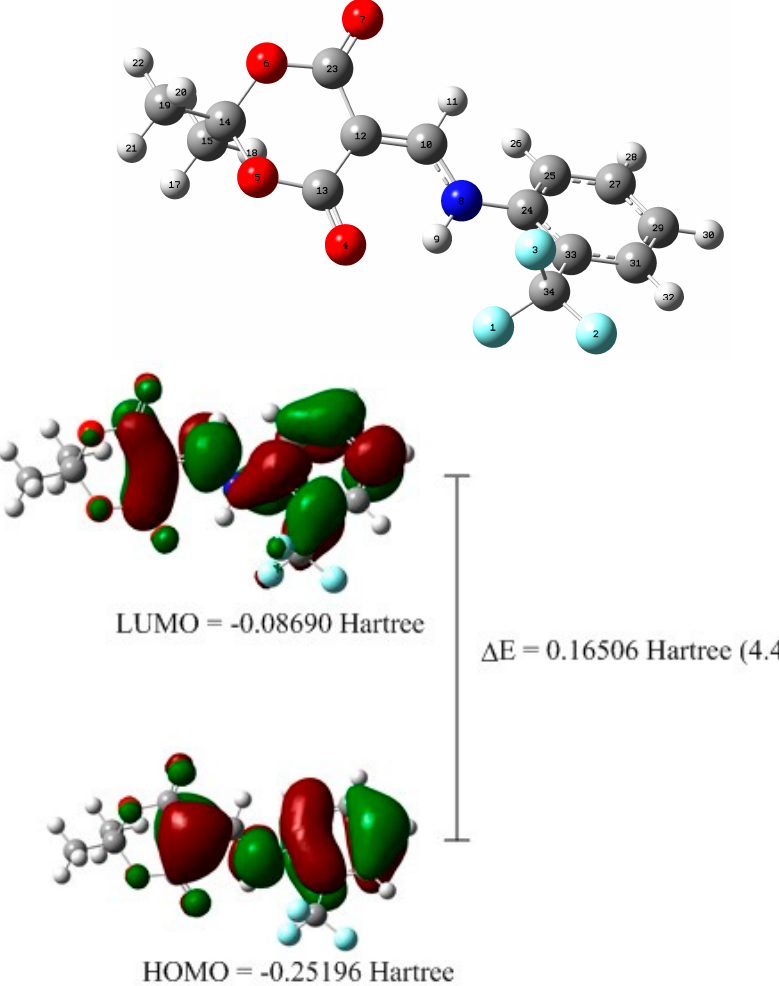
Figure 3. Optimized geometry and frontier molecular orbitals of the compound 3 .